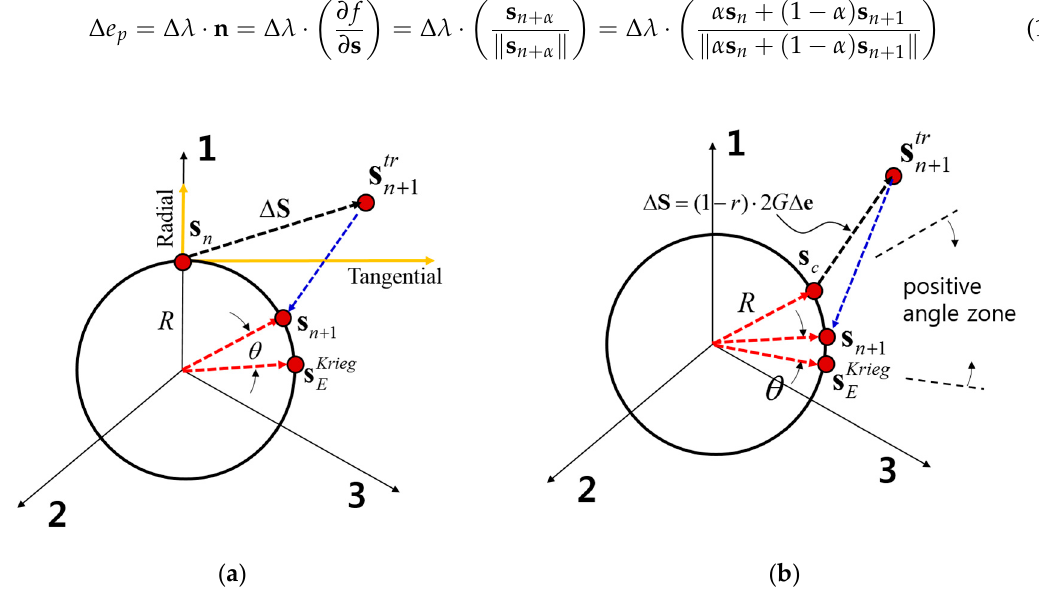
Figure 3. Deviatoric principal stress plane: ( a ) radial and tangential coordinates at the contact stress, s c = s n , and ( b ) positive angular error θ shown between computed and exact stress is identified at each trial stress state, s tr . s n + 1 is the final stress which was corrected by the radial return method. Note: r is the distance proportion between s n and s c over the time interval.